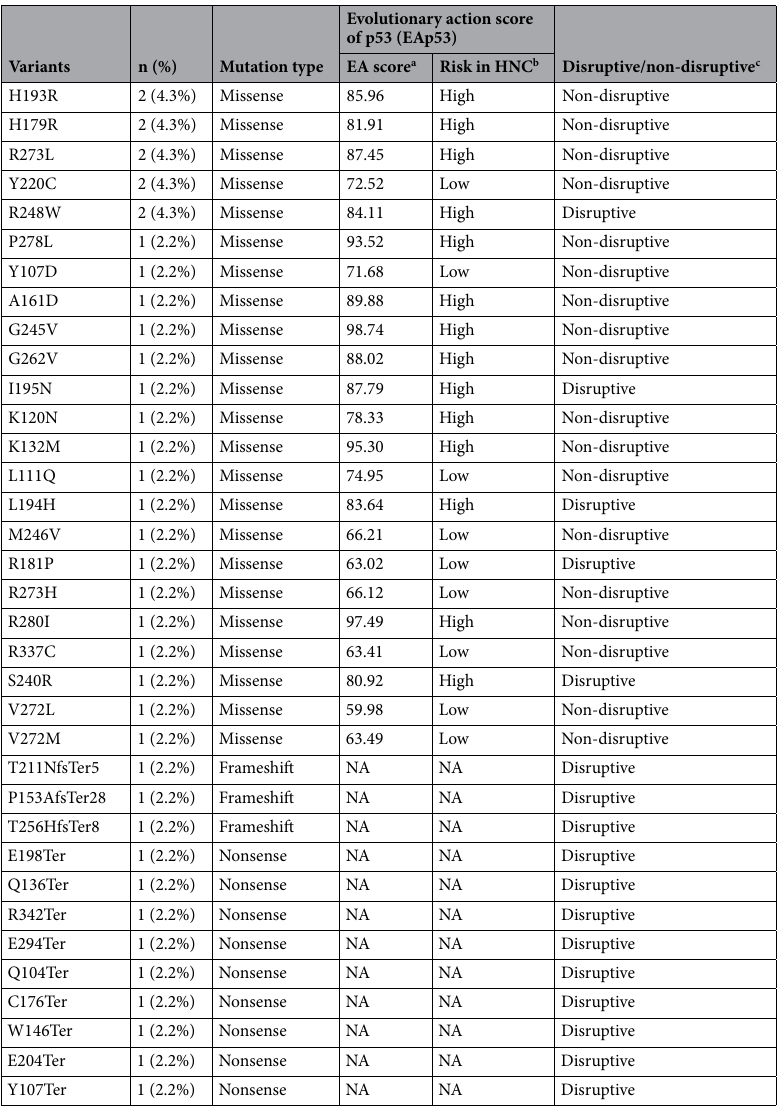
Table 2. Classification of TP53 mutations. NA not applicable, n number of cases. a http:// mammo th. bcm. Mutations Associated with Decreased Survival and Increased Distant Metastases in Head and Neck Cancer, Cancer Res. 2015 Apr 1;75(7):1527–36; n number of variants. c Poeta et al. TP53 mutations and survival in squamous-cell carcinoma of the head and neck. N Engl J Med 357, 2552–2561, https:// doi. org/ 10. 1056/ NEJMo a0737 70